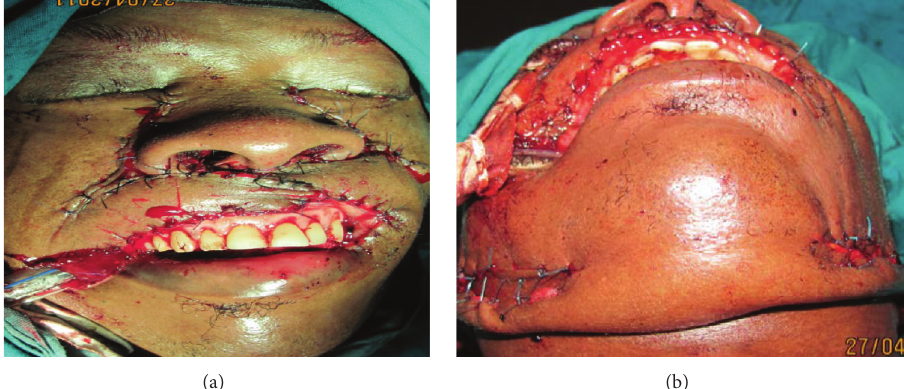
Figure 3: Insertion of bilateral nasolabial flaps and elevation of bipedicled mental